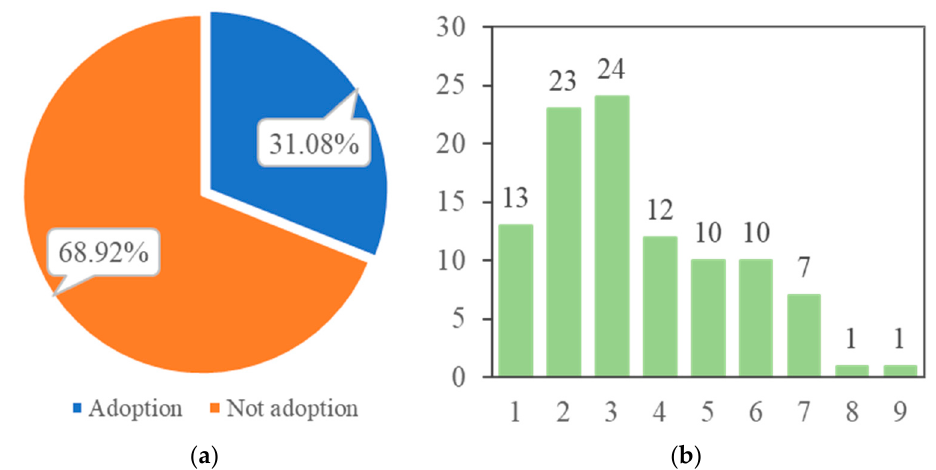
Figure 3. The situation of farmers’ earthquake-preparedness behaviors. ( a ) Distribution of adopted and not adopted earthquake disaster-preparedness behaviors in the sample; ( b ) Frequency distribution of adopting disaster-preparedness behaviors in the